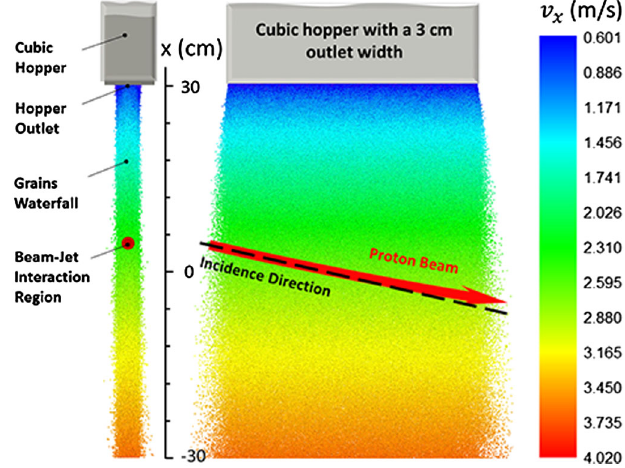
FIG. 2. Schematic representation of beam-target interaction for a granular waterfall target. The velocity variance of the waterfall is